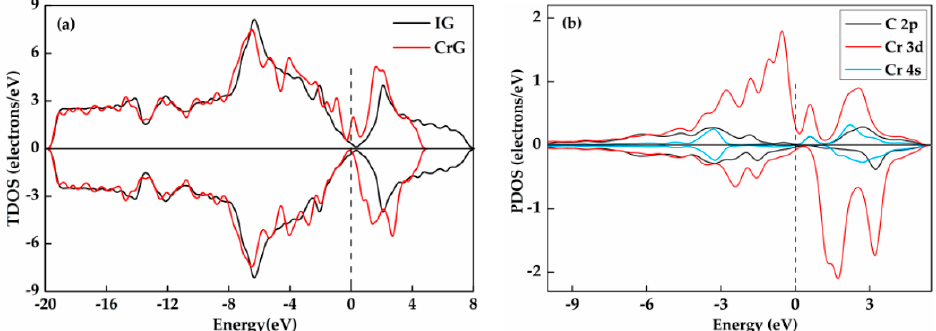
Figure 6. The TDOS (a) and PDOS (b) of CrG system at T doping site. The “+” for alpha-spin, “-” for beta-spin in the TDOS plot.